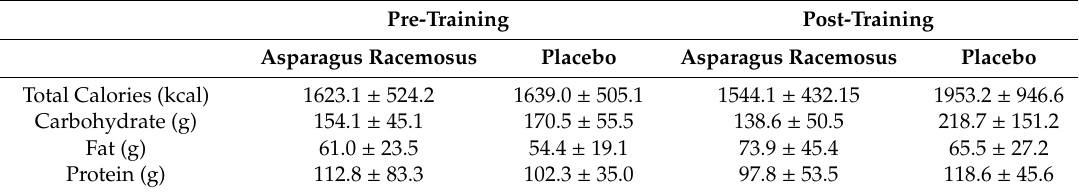
Table 3. Mean ± SD of total calories, carbohydrate, fat, and protein consumption across 3 days before and after training.